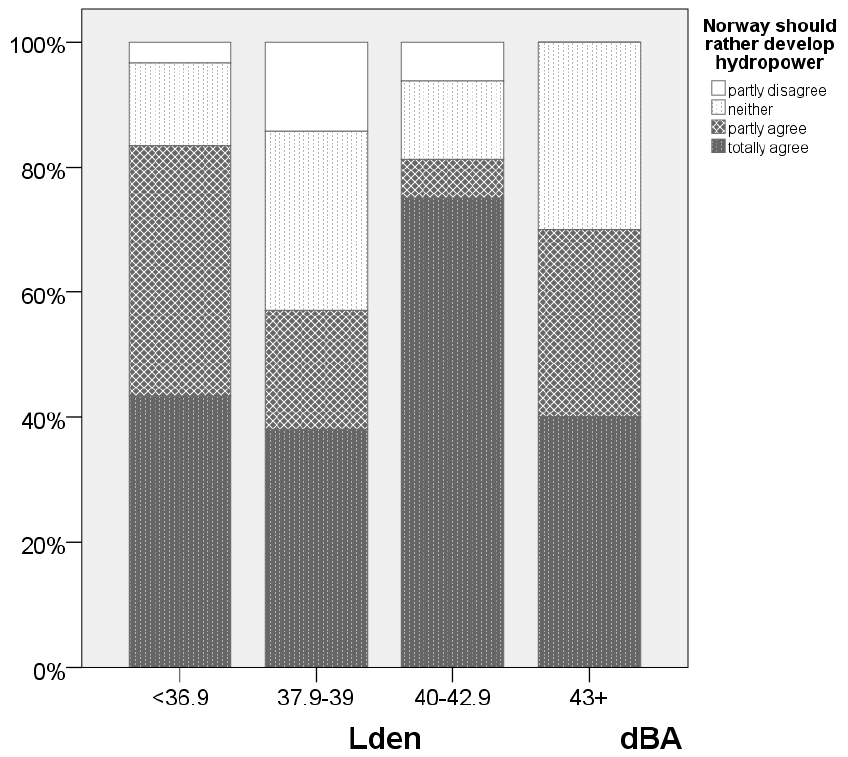
Figure 14. Level of agreement with the statement that Norway should rather develop hydropower.